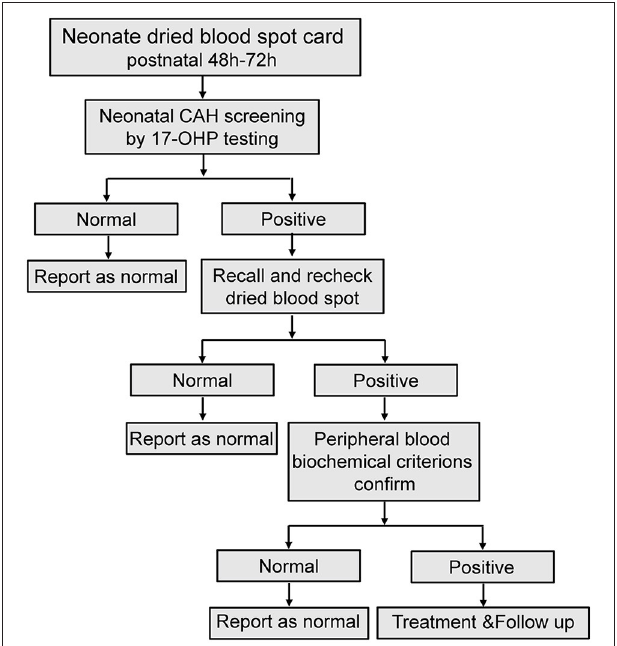
FIGURE 1 | Flowchart for neonatal CAH screening. Recall and recheck dried blood spot recheck, re-analysis with another new dried blood spot from the recalled patient; Peripheral blood biochemical criterions confirm, analysis peripheral blood sample of biochemical criterions from recalled